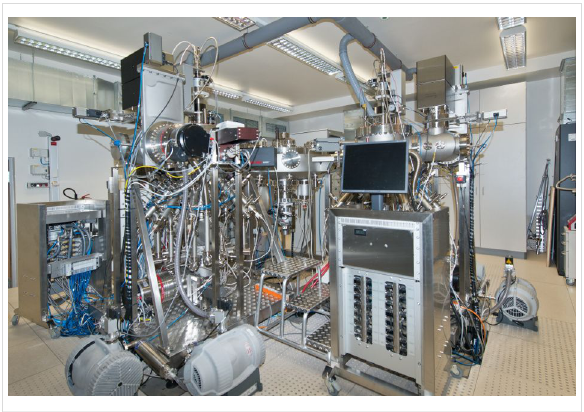
Figure 1: Photo of the dual chamber ALL-oxide MBE system installed in the Max-Planck Institute for Solid State Research.